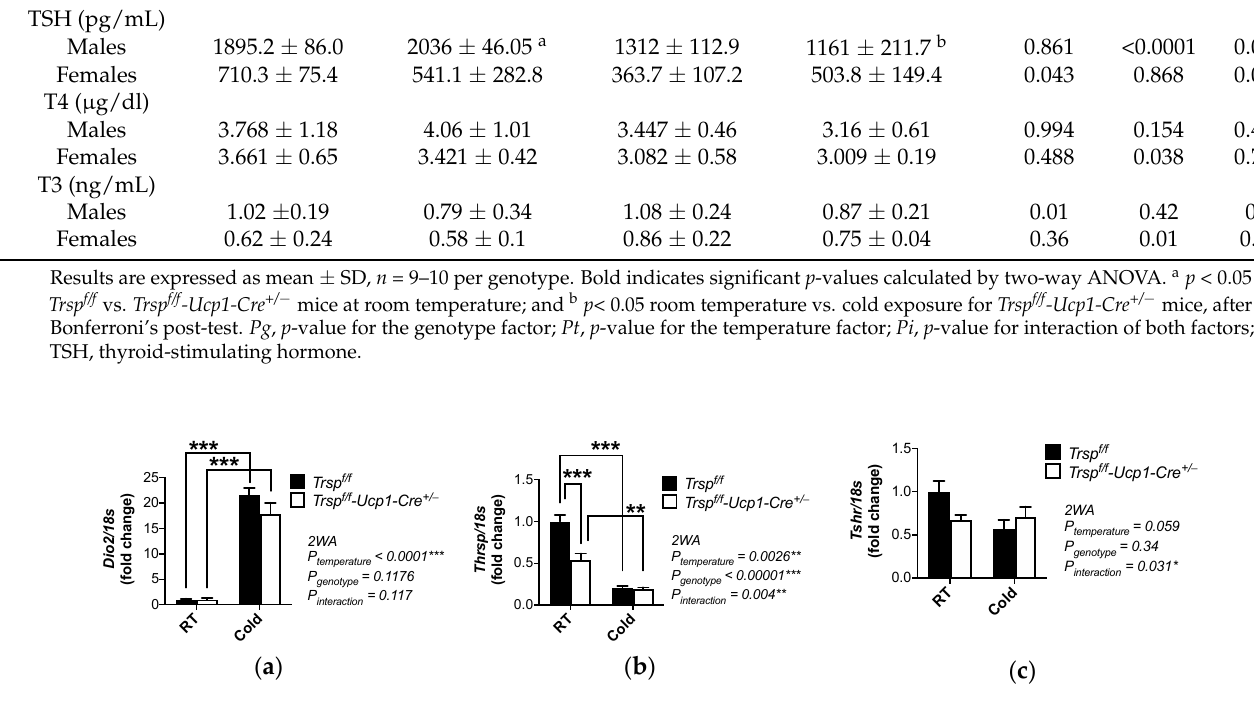
Figure 8. Gene expression of thyroid hormone responsive transcripts in male Trsp f/f and Trsp f/f -Ucp1-Cre +/ − mice . Expression levels of ( a ) Dio2 , ( b ) Thrsp (i.e., Spot14 ), and ( c ) Tshr were assessed by qPCR. RT, room temperature. Data are mean + SD; n = 8–10 per genotype. p -values are displayed in graphs and calculated by two-way ANOVA followed by Bonferroni’s post-test. * p < 0.05, ** p < 0.01 and *** p < 0.001.